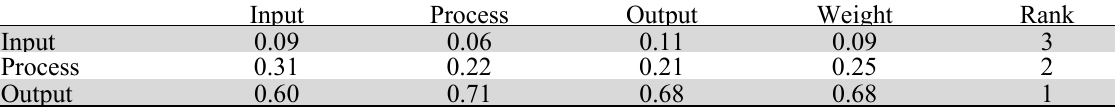
Normalized Matrix and weight of factor production to goal